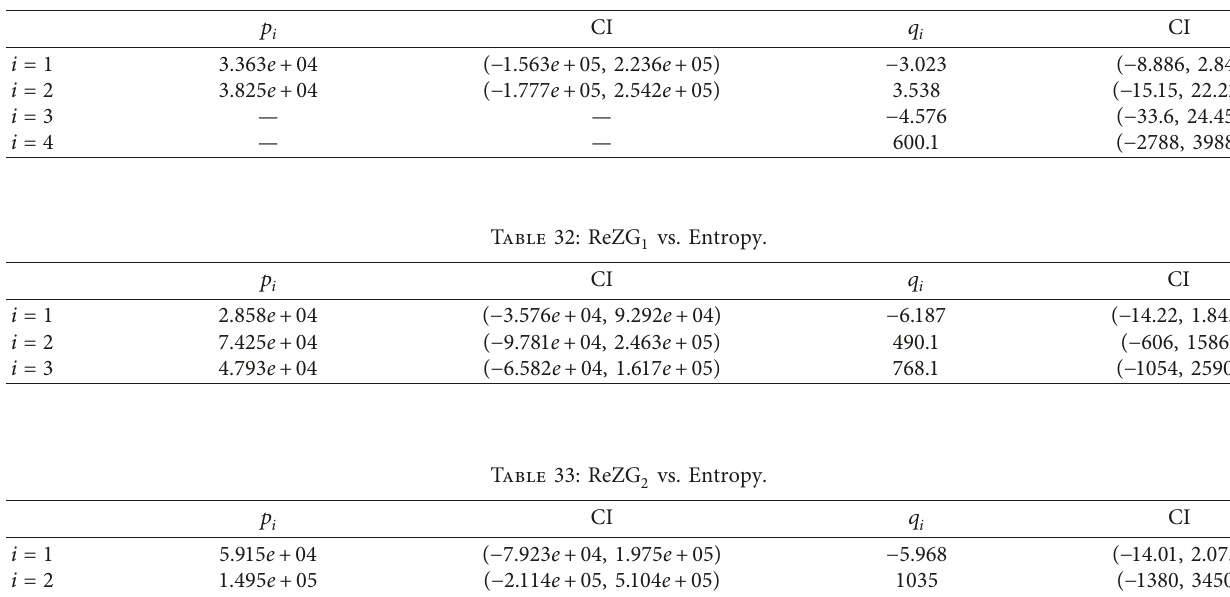
Table 31: F vs. Entropy.